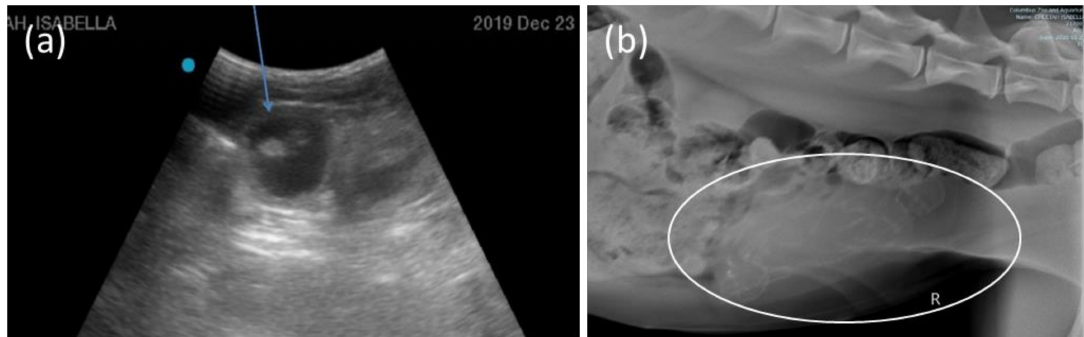
Figure 3. Pregnancy monitoring of recipient female by ultrasonography 32 days post-transfer, the arrow is pointing at the embryonic vesicle filled with fluid ( a ) and radiography 62 days post-transfer, mineralized skeletons of both cubs are visible within the circle ( b